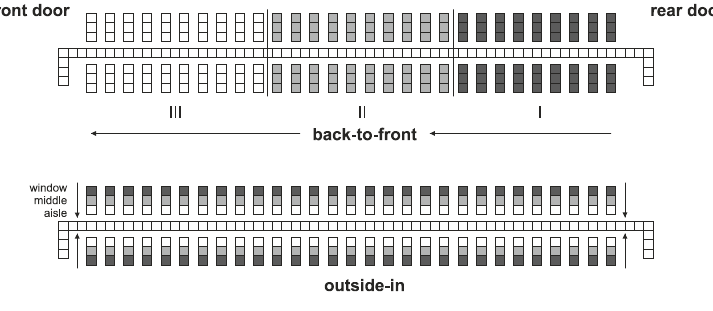
Figure 2. Example for back-to-front and outside-in boarding strategy (darker seats are boarded first, block sequence is I-II-III) modelled in the simulation environment.